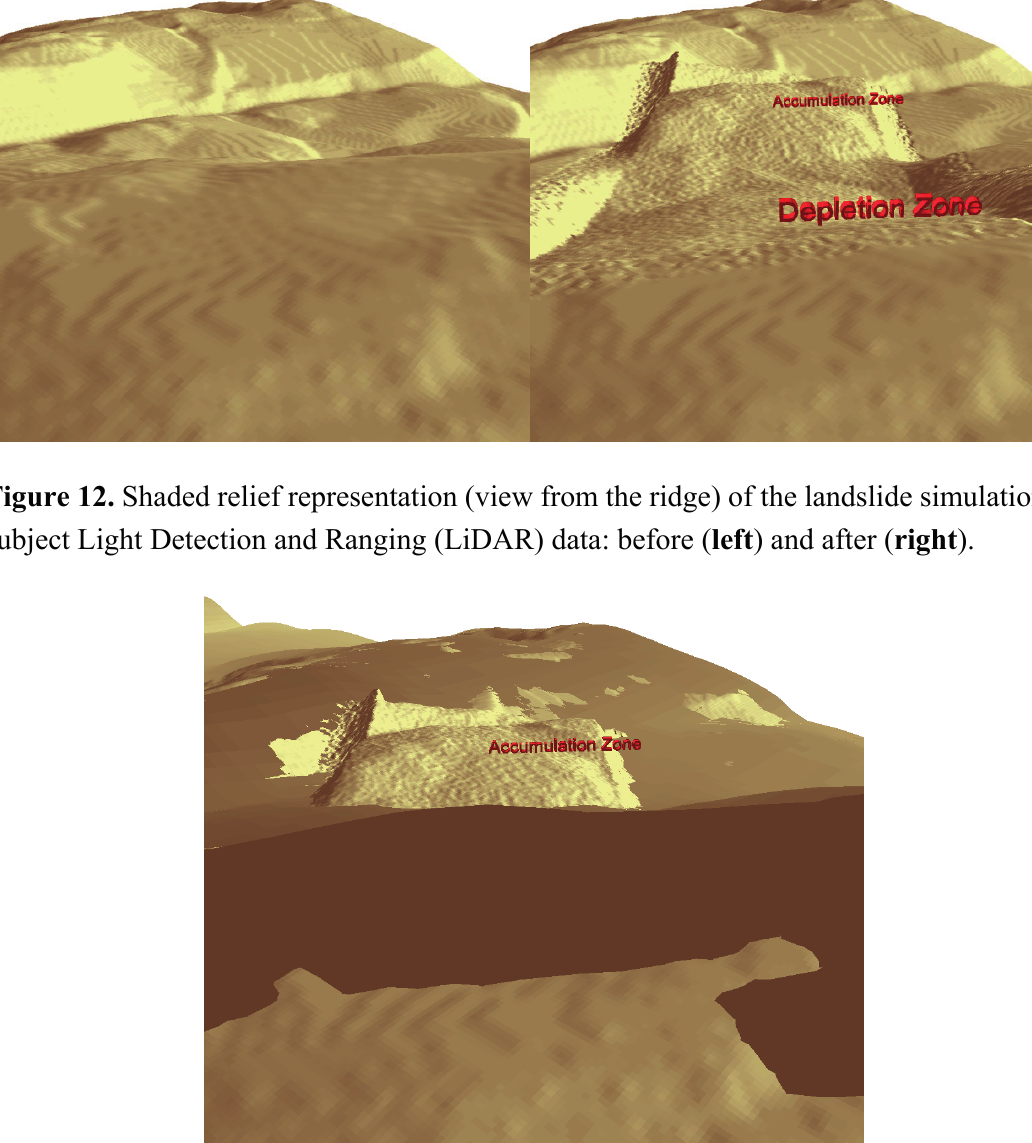
Figure 13. LiDAR topography superimposed on the DTM